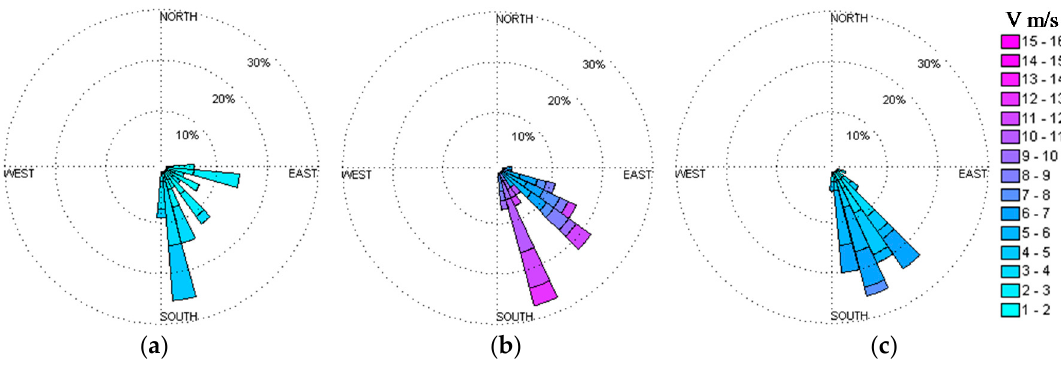
Figure 6. P4 wind roses for ( a ) NUIG measured wind, and HR modeled winds at ( b ) C1 and ( c ) A2.